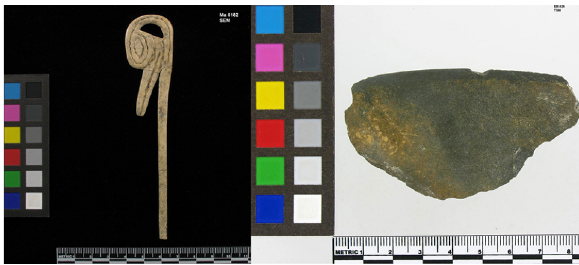
Figure 2 | Blanket pin and slate blade. Courtesy Reciprocal Research